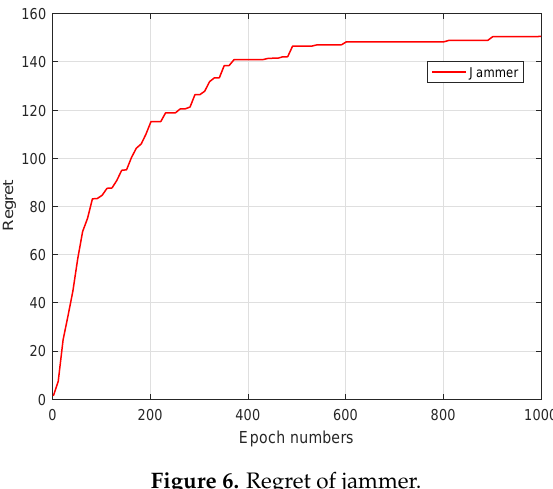
Figure 6. Regret of